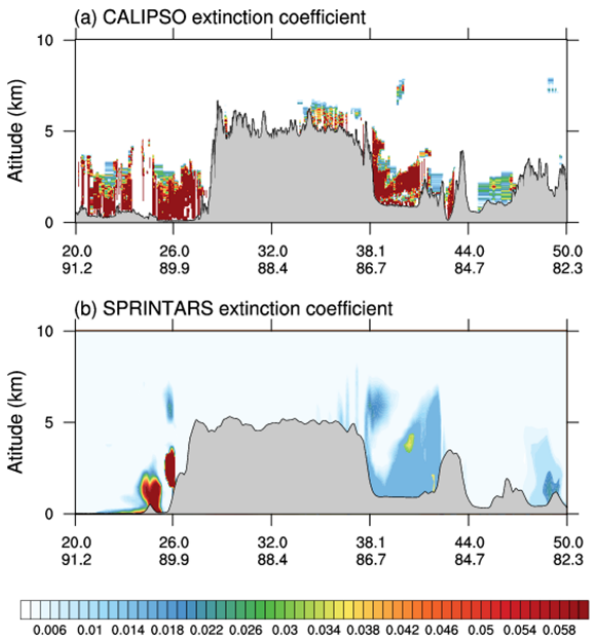
Figure 5. The vertical cross-section of the aerosol extinction coef- ficient (unit: km − 1 ) from (a) CALIPSO and (b) the simulation by SPRINTARS on 22 August 2007. The gray shading indicates the